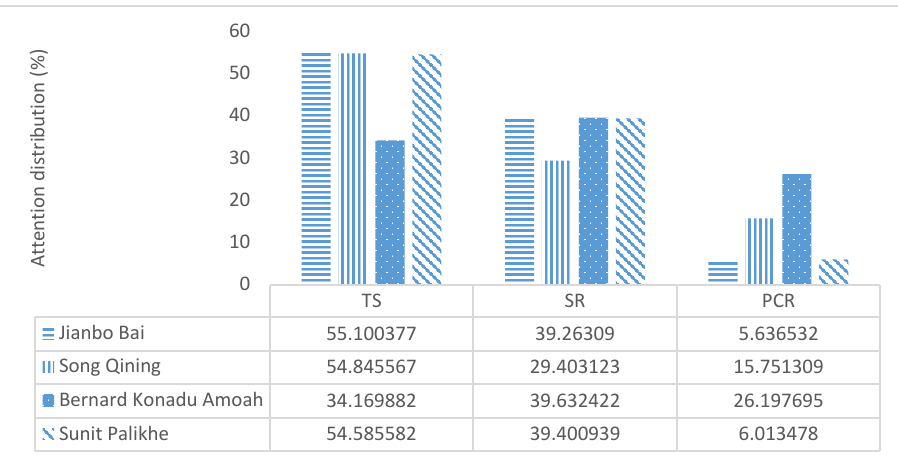
Figure 8. Attention distribution of